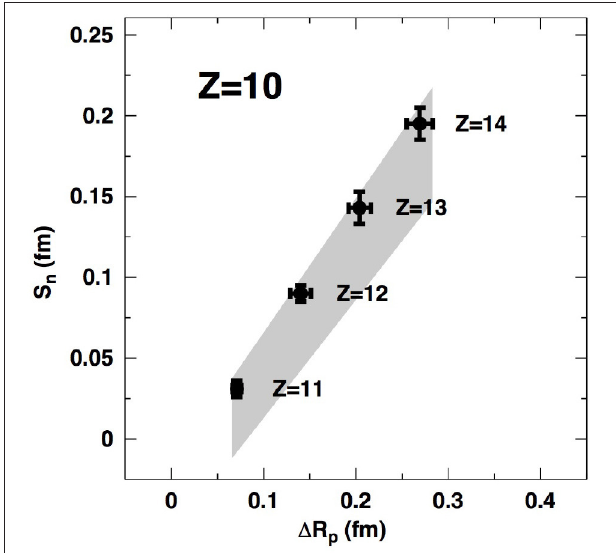
FIGURE 2 | Graphical representation of Table 4 . The gray band signifies Equations (10-11).